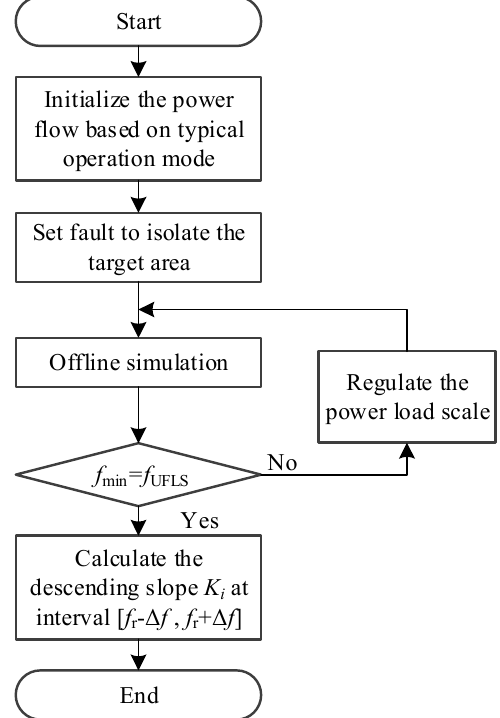
Figure 4. The process to calculate the response index K of intelligent home appliances.